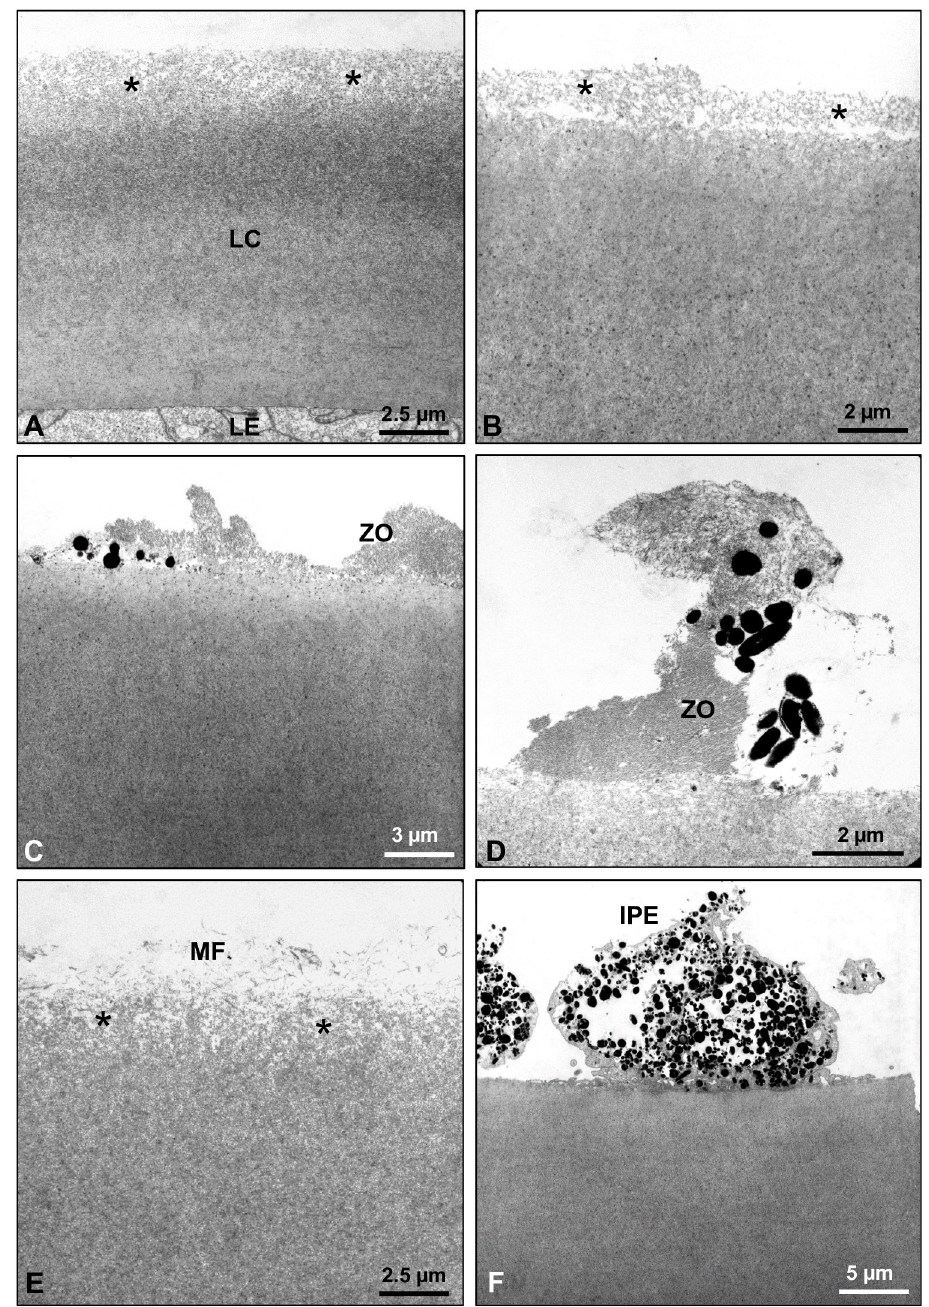
Fig 5. Transmission electron micrographs of lens capsule specimens showing various alterations of the capsular surface. (A, B) Roughened and loosely structured surface layer (asterisks) of the lens capsule (LC), which was focally detaching from the capsule. (C, D) Remnants of zonular fibers (ZO) forming the zonular lamella with adherent pigment granules. (E) Deposition of microfibrils (MF) onto the roughened capsule surface (asterisks). (F) Remnants of iris pigment epithelium (IPE) on the capsule surface. (LE, lens epithelium).